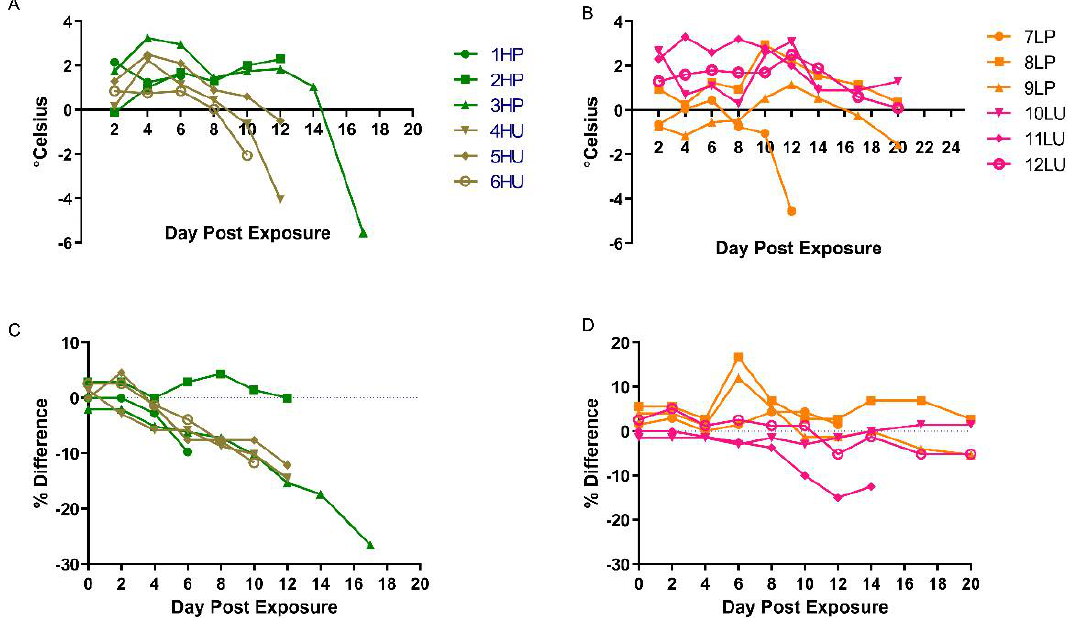
Figure 2. Temporal baseline-corrected temperatures and weights. Baseline-corrected temperatures (degree change from baseline) of cynomolgus macaques exposed to purified (high dose/purified = HP and low dose/purified = LP) or crude (high dose/unpurified = HU and low dose/unpurified = LU) monkeypox virus by individual animals; high dose ( A ) and low dose ( B ). Baseline-corrected (% difference) changes in weight of nonhuman primates intravenously exposed to monkeypox, using either purified or crude material at high ( C ) or low ( D ) concentrations of virus.